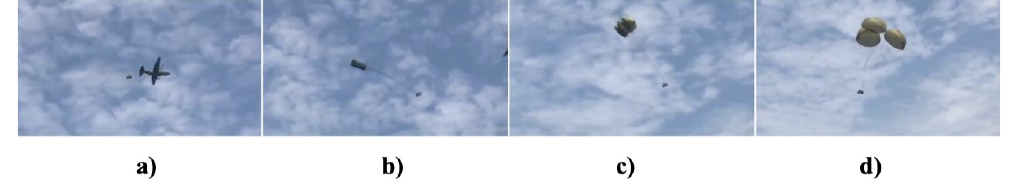
Figure 1. Parachute movement stage: ( a ) free fall stage; ( b ) straightening stage; ( c ) inflatable stage; ( d ) steady descent